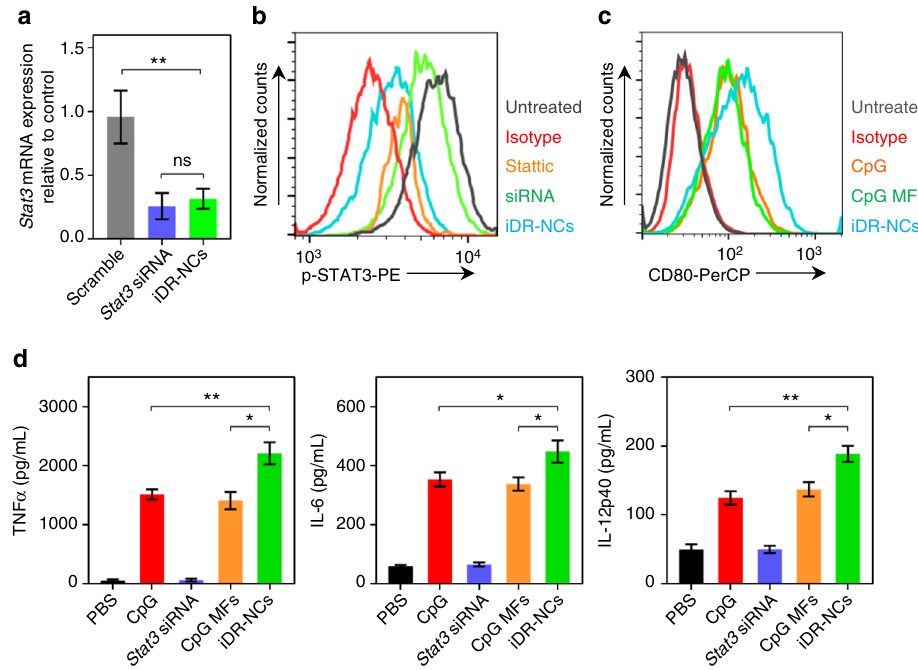
Fig. 5 Synergistic in vitro immunostimulation of iDR-NC nanoadjuvants. a Real-time quantitative RT-PCR results showing Stat3 silencing in DC2.4 cells treated with iDR-NCs for 48 h. Stat3 siRNA and scramble served as controls. b Flow cytometry results showing that p-STAT3 expression was down- regulated in DC2.4 cells treated with iDR-NCs for 48 h. STAT3 inhibitor (Sttatic) and Lipofectamine2000-transfected Stat3 siRNA were used as controls. Stat3 shRNA: 100 nM equivalents in a , b . c Flow cytometry results showing that iDR-NCs (100 nM CpG equivalents) elevated the expression of costimulatory factor CD80 in DC2.4 cells after 24 h. d ELISA results suggest iDR-NCs (200 nM CpG equivalents) induced DC2.4 cells to secrete signi fi cantly more TNF α , IL-6, and IL-12p40 than CpG or CpG MFs, after 24 h. Stat3 siRNA alone was used as a control. (ns: non-signi fi cant; * p < 0.05; ** p < 0.01; n = 3; one-way ANOVA with Bonferroni post-hoc test). Data represented as mean ±